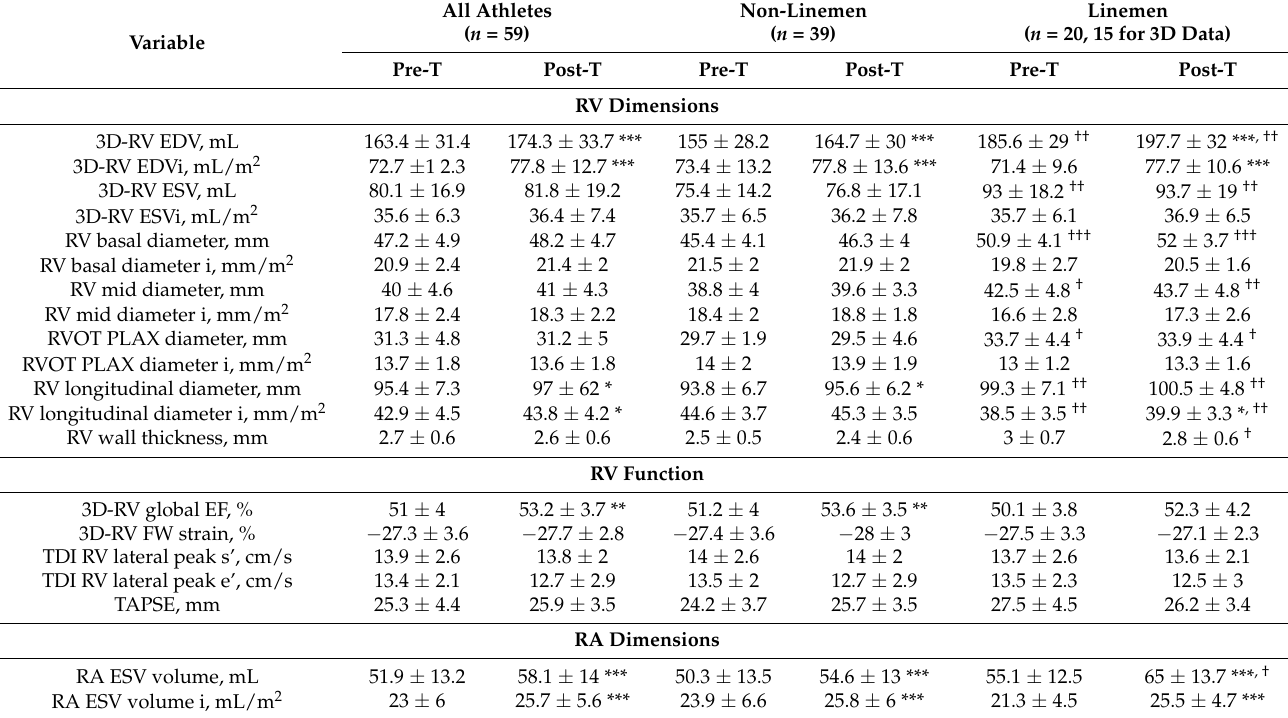
Table 2. Comparison of pre-training (pre-T) and post-training (post-T) right ventricular (RV) and atrial (RA) parameters. All Athletes ( n = Variable